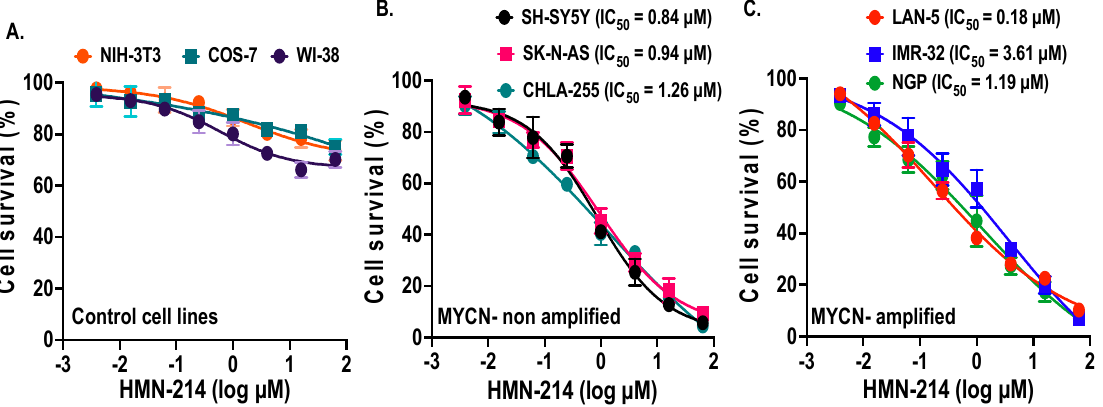
Figure 2. HMN-214 inhibits NB proliferation. Cell proliferation assays in response to HMN-214 using six human NB cell lines and three control fibroblast cell lines. ( A ) Control fibroblast cell lines (WI-38, NIH-3T3, COS-7). ( B ) MYCN-non-amplified cell lines (SH-SY5Y, SK-N-AS, CHLA-255). ( C ) MYCN amplified cell lines (NGP, LAN-5, CHLA-255-MYCN). Respective IC 50 values are indicated.